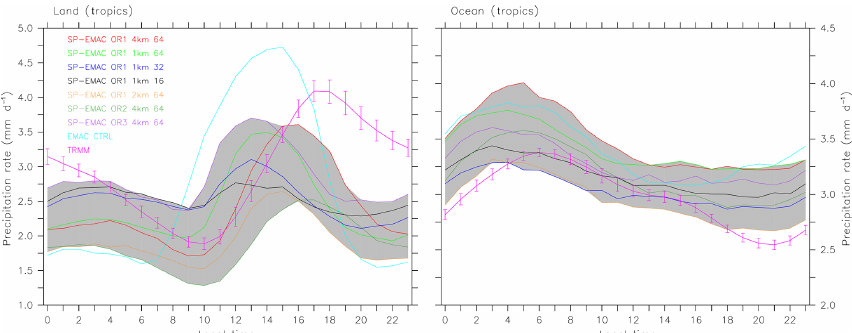
Figure 6. Comparison of diurnal tropical precipitation (30 ◦ around the Equator) for land and ocean with 3-hourly Tropical Rainfall Measuring Mission (TRMM) data ∗ between 1998 and 2010 for the month of July. The observational standard deviation is shown by error bars indicating interannual variability in the diurnal cycle. The grey area covers the variability of all SP-EMAC configurations. ∗ TRMM (2011), TRMM (TMPA) rainfall estimate, L3, 3h, 0 . 25 ◦ × 0 . 25 ◦ , V7, Greenbelt, MD, Goddard Earth Sciences Data and Information Services Center (GES DISC); https://doi.org/10.5067/TRMM/TMPA/3H/7; Huffman et al.